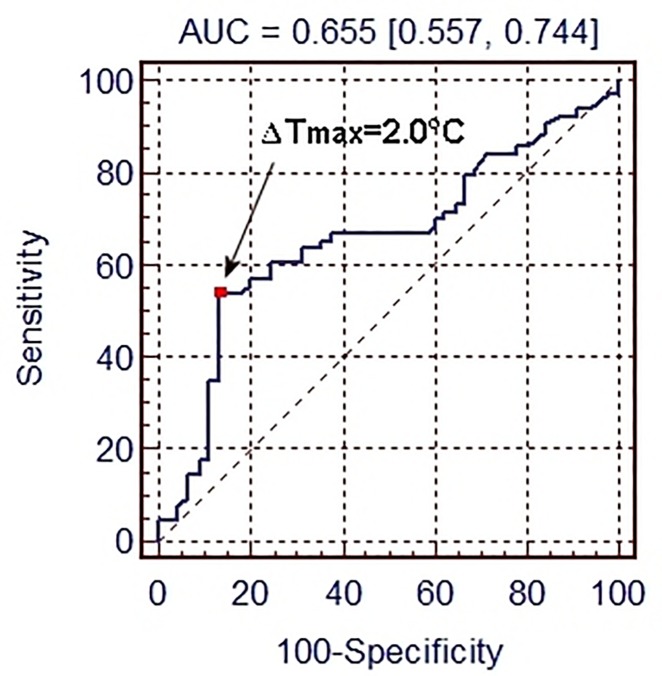
Receiver Operating Characteristic curve.Receiver Operating Characteristic curve for ΔTmax with indicated cut-off score ΔTmax = 2°C, for which sensitivity (SE) is 54.6%, specificity (SP) is 88.0% and area under curve is AUC = 0.655.